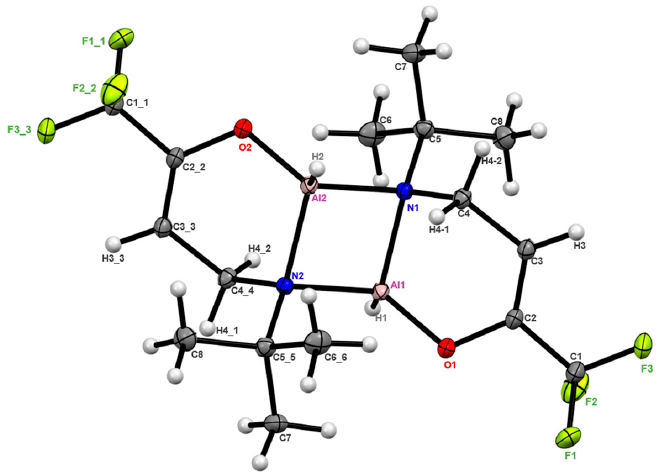
Figure 4. The ORTEP drawing of complex 4a with thermal ellipsoids drawn at 50% probability level.